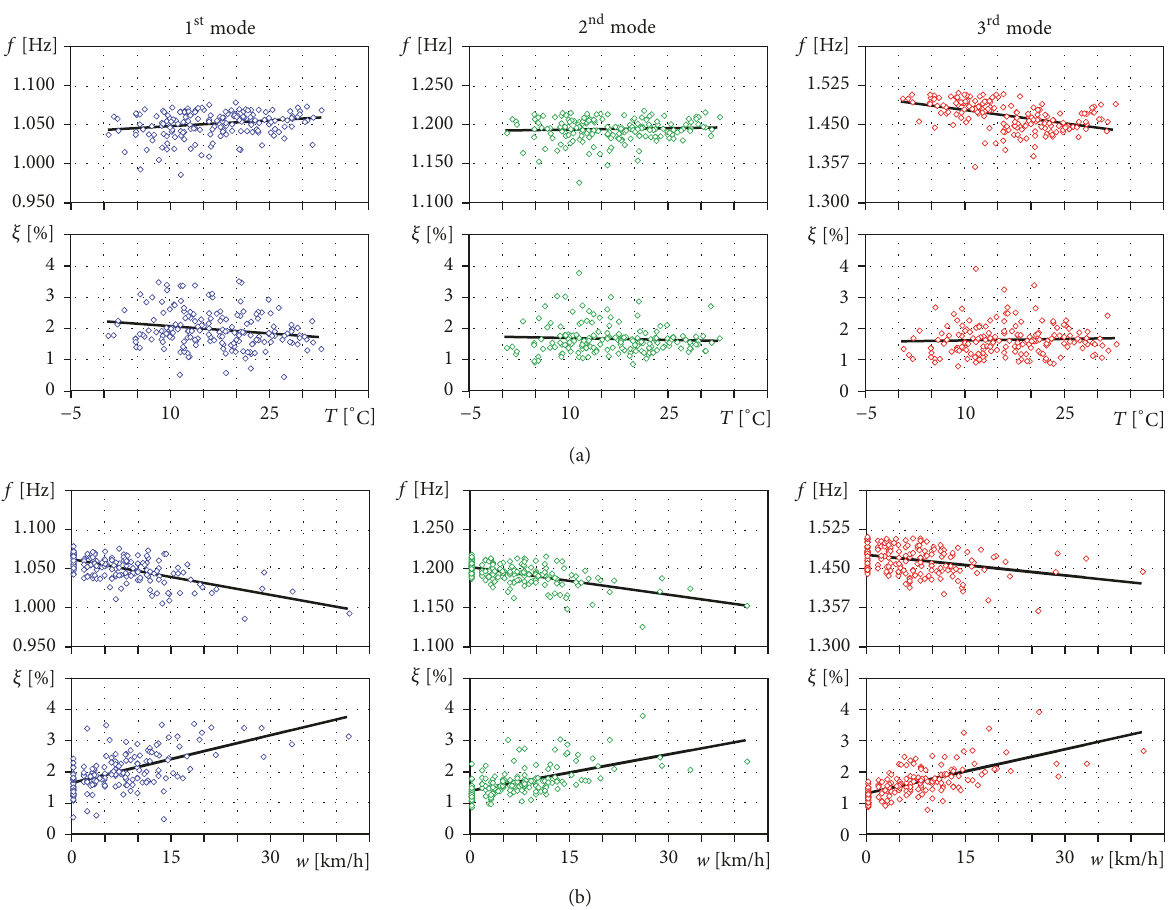
Figure 12: Variation of frequencies and damping ratios: (a) variations with respect to temperature and (b) variations with respect to wind velocity.